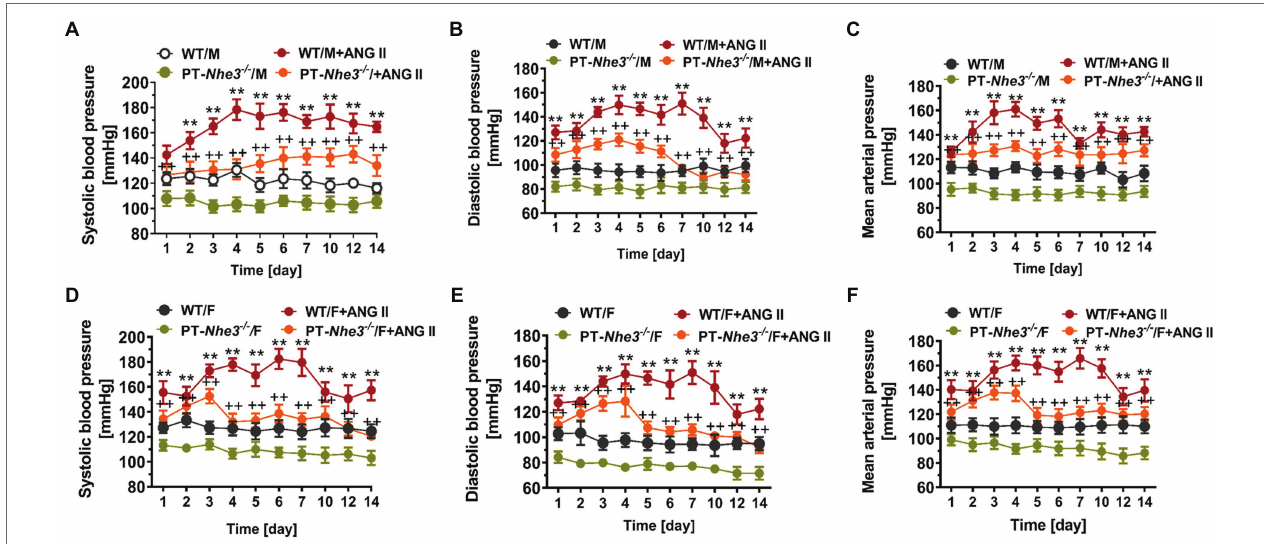
FIGURE 3 | Systolic, diastolic, and mean arterial blood pressure responses to a pressor dose of Ang II infusion, 1.5 mg/kg/day, i.p., via osmotic minipump in conscious, adult male (M) and female (F) wild-type (WT) and PT -Nhe3 − / − mice, as measured continuously for 14 days using the direct implanted telemetry technique. Please note the time-dependent increases in systolic (A,D) , diastolic (B,E) , and mean arterial blood pressure responses (C,F) in male and female WT mice, and significantly attenuated hypertensive responses to Ang II in male and female PT -Nhe3 − / − mice. WT/M, male WT; WT/M+Ang II, male WT with Ang II infusion; PT-Nhe3 − / − /M, male PT-Nhe3 − / − ; and PT-Nhe3 − / − /+Ang II, male PT-Nhe3 − / − with Ang II infusion. F represents female WT or PT-Nhe3 − / − mice. ** p < 0.01 vs. WT time-control group and ++ p < 0.01 vs. PT -Nhe3 − / − time-control group, respectively. N = 5–12 per group. Reproduced with permission (Li et al.,